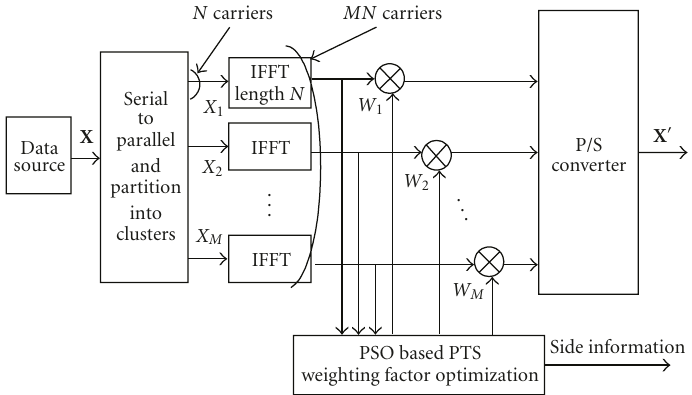
Figure 1: The structure of transmitter with PSO-based PTS